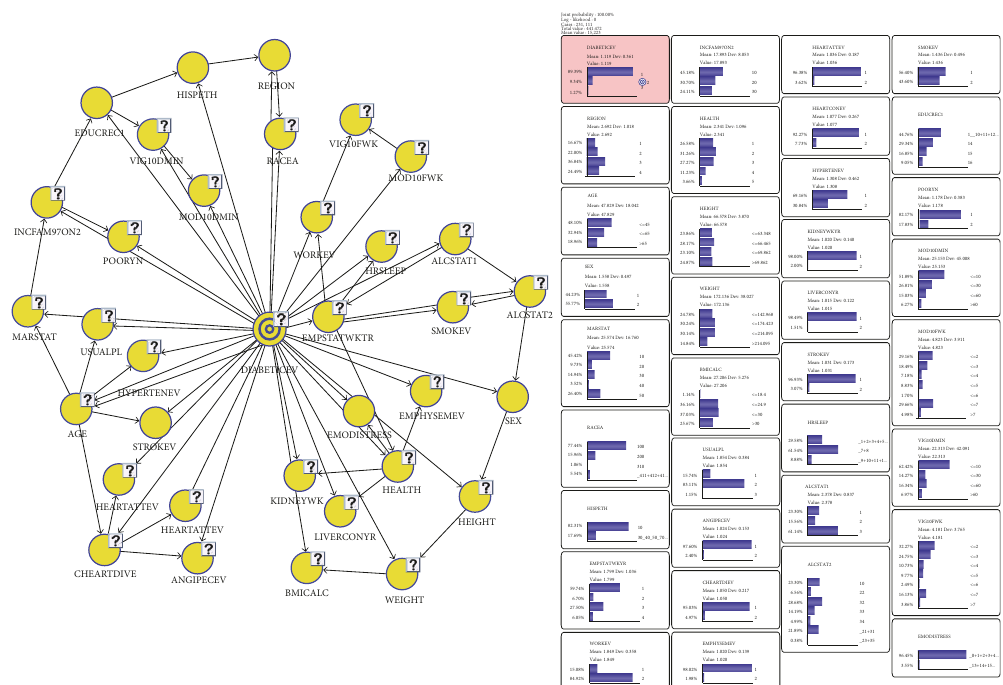
Figure 1: Bayesian Belief Network model of diabetes using the 2004 – 2013 National Health Interview